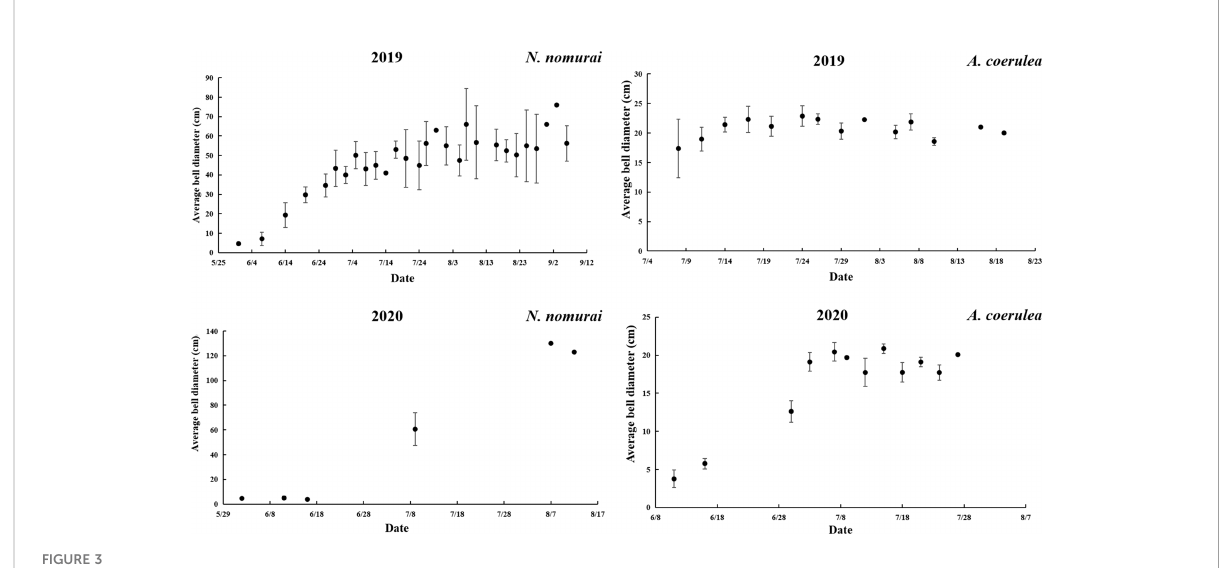
FIGURE 3 The BDs of N. nomurai and A. coerulea in 2019 and